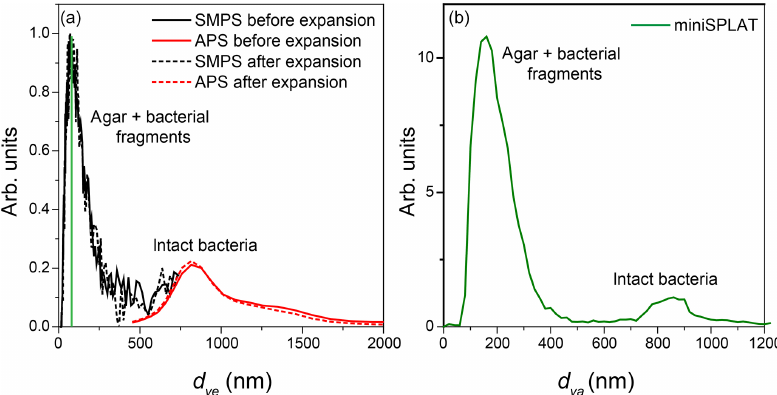
Figure 7. (a) Size distributions of an aerosolized suspension of PF CGina particles in the AIDA cloud chamber before and after Expansion 2 calculated from the SMPS and the APS measurements; (b) miniSPLAT-measured size distribution of PF CGina particles in the chamber before Expansion 2. The miniSPLAT small particle detection limit is denoted by the green line in panel (a)